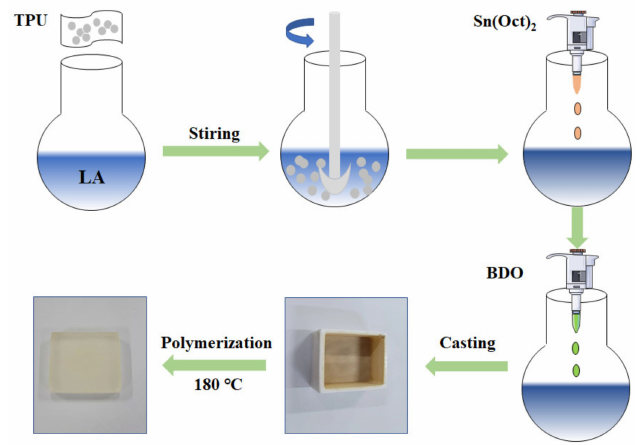
Figure 1. Preparation process of PLA-TPU